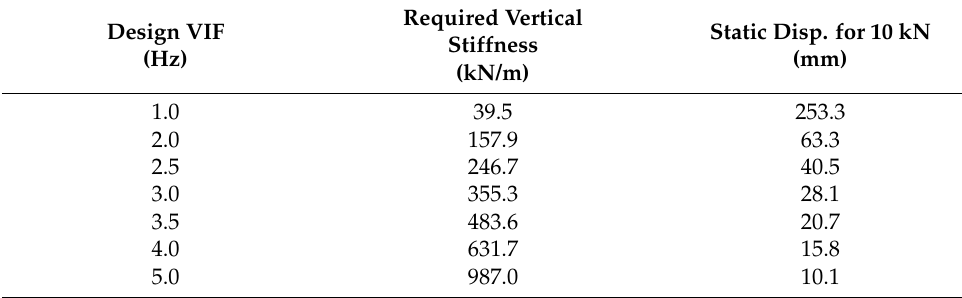
Table 2. Parameter values for simple seismic analysis model.